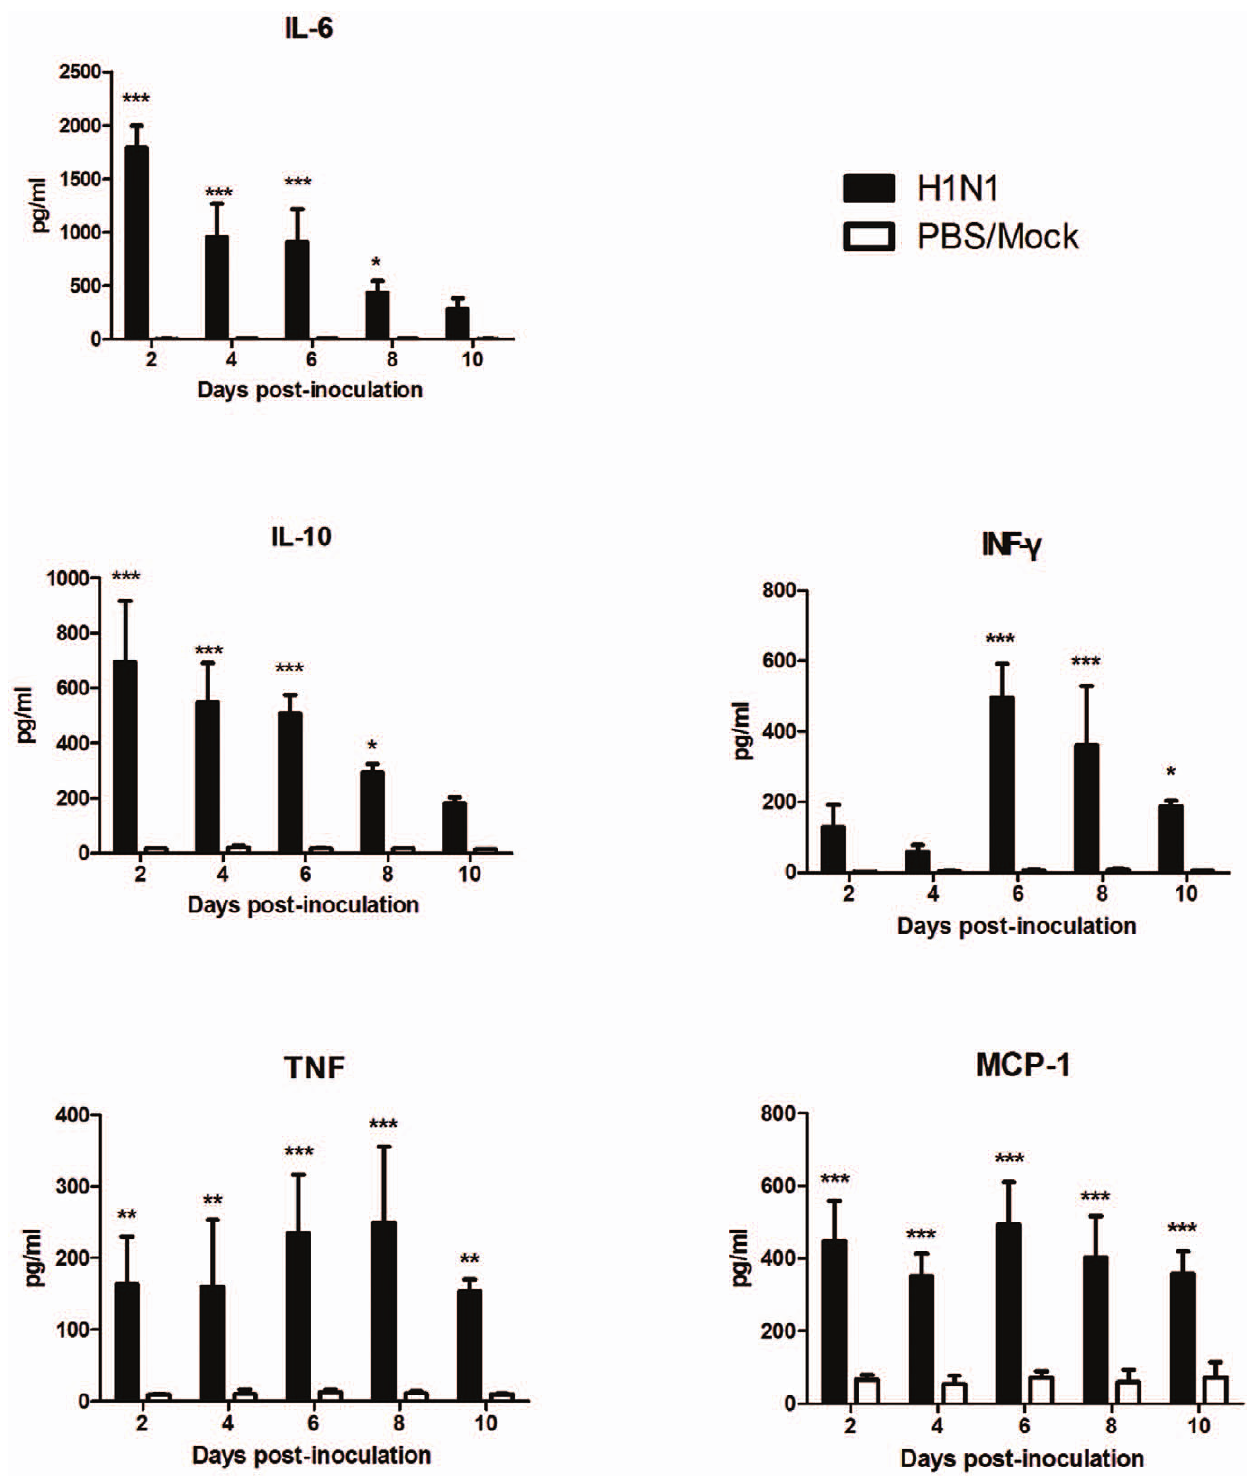
Figure 5. Cytokine levels in virus-infected mouse lungs. Mice were euthanized at indicated times p.i. The collected lungs were weighed, and 10% homogenates were prepared in cold PBS. Cytokine levels from lung homogenates were measured using the Cytokine Bead Array system. *p , 0.05, **p , 0.01, ***p , 0.001, comparison between virus-infected and control groups. doi:10.1371/journal.pone.0029347.g005 [17], but only the a -2,3-linked SA receptor is found in the mouse virus to induce ARDS in mice; however, animals inoculated with a respiratory tract [20]. Therefore, such a typical 2009 H1N1 virus high dose of CA/04 virus (10 6.5 pfu) only showed moderate respiratory symptoms, and no lethality was observed (unpublished may not be able to induce ARDS in mice. In fact, we used CA/04